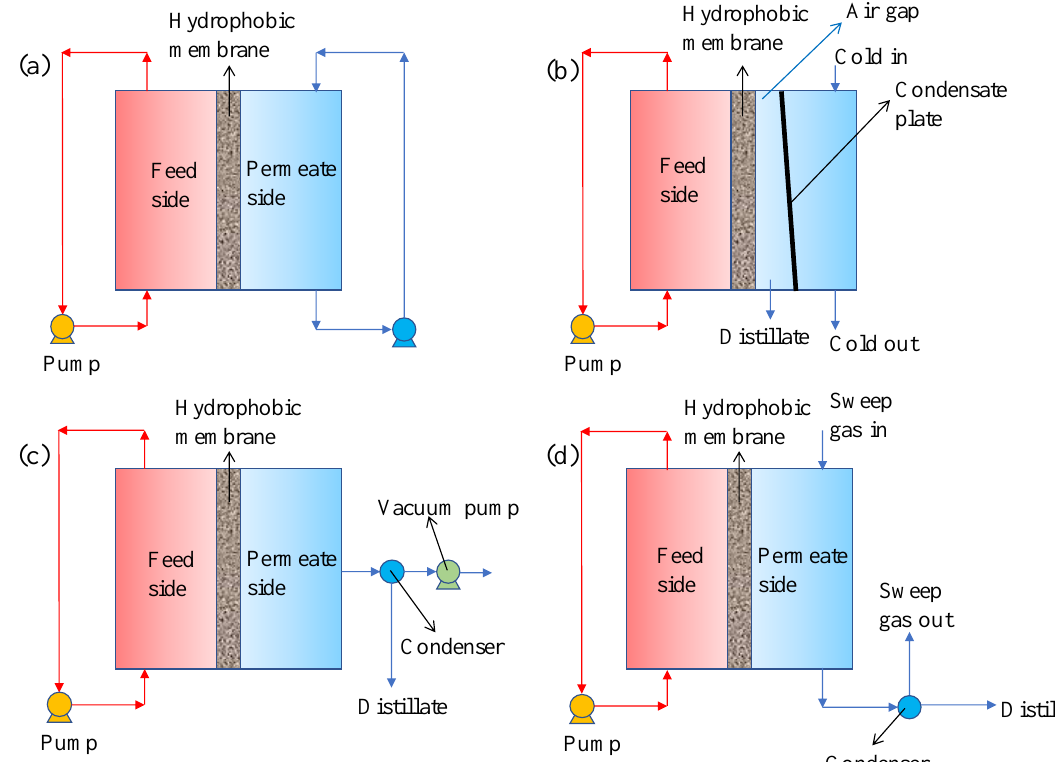
Figure 2. Schematic diagram of four typical MD configurations: ( a ) DCMD, ( b ) AGMD, ( c ) VMD, and ( d ) SGMD.